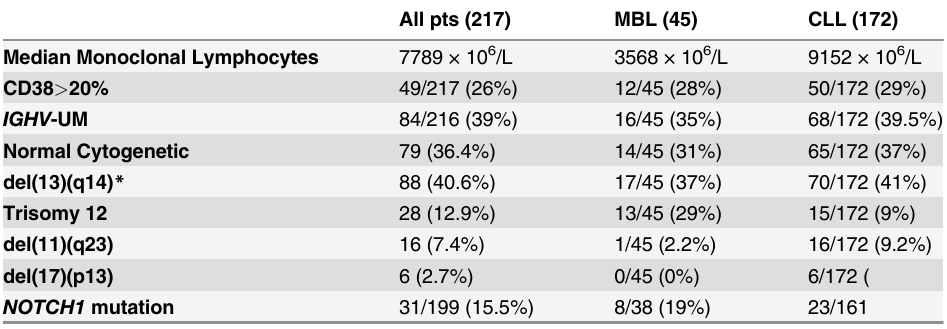
Table 1. Clinical and biological features of patients enrolled in the O-CLL1 protocol and investigated by gene expression pro fi